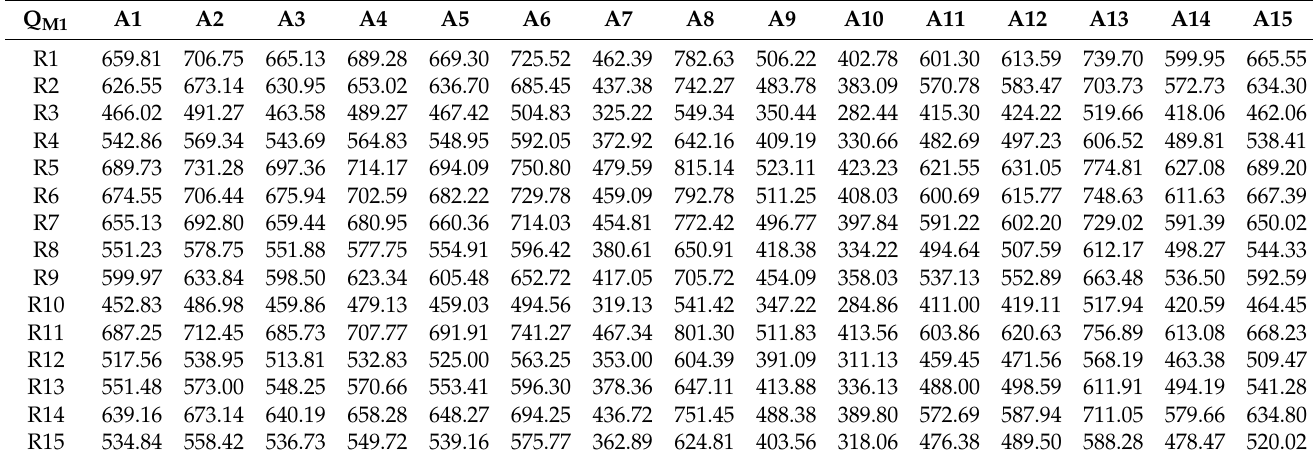
Table 8. Integrated relational matrix by considering three matrices (Q M1